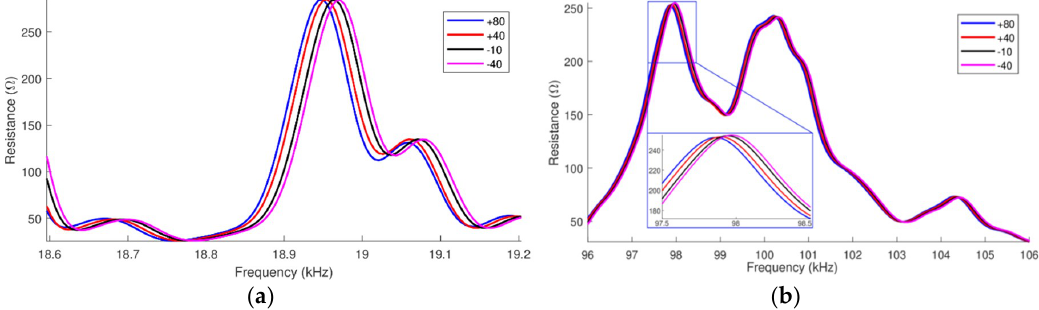
Figure 5. Horizontal shift of the impedances (real part) pipe-1/PZT-1: ( a ) at low frequency and ( b ) at high frequency.